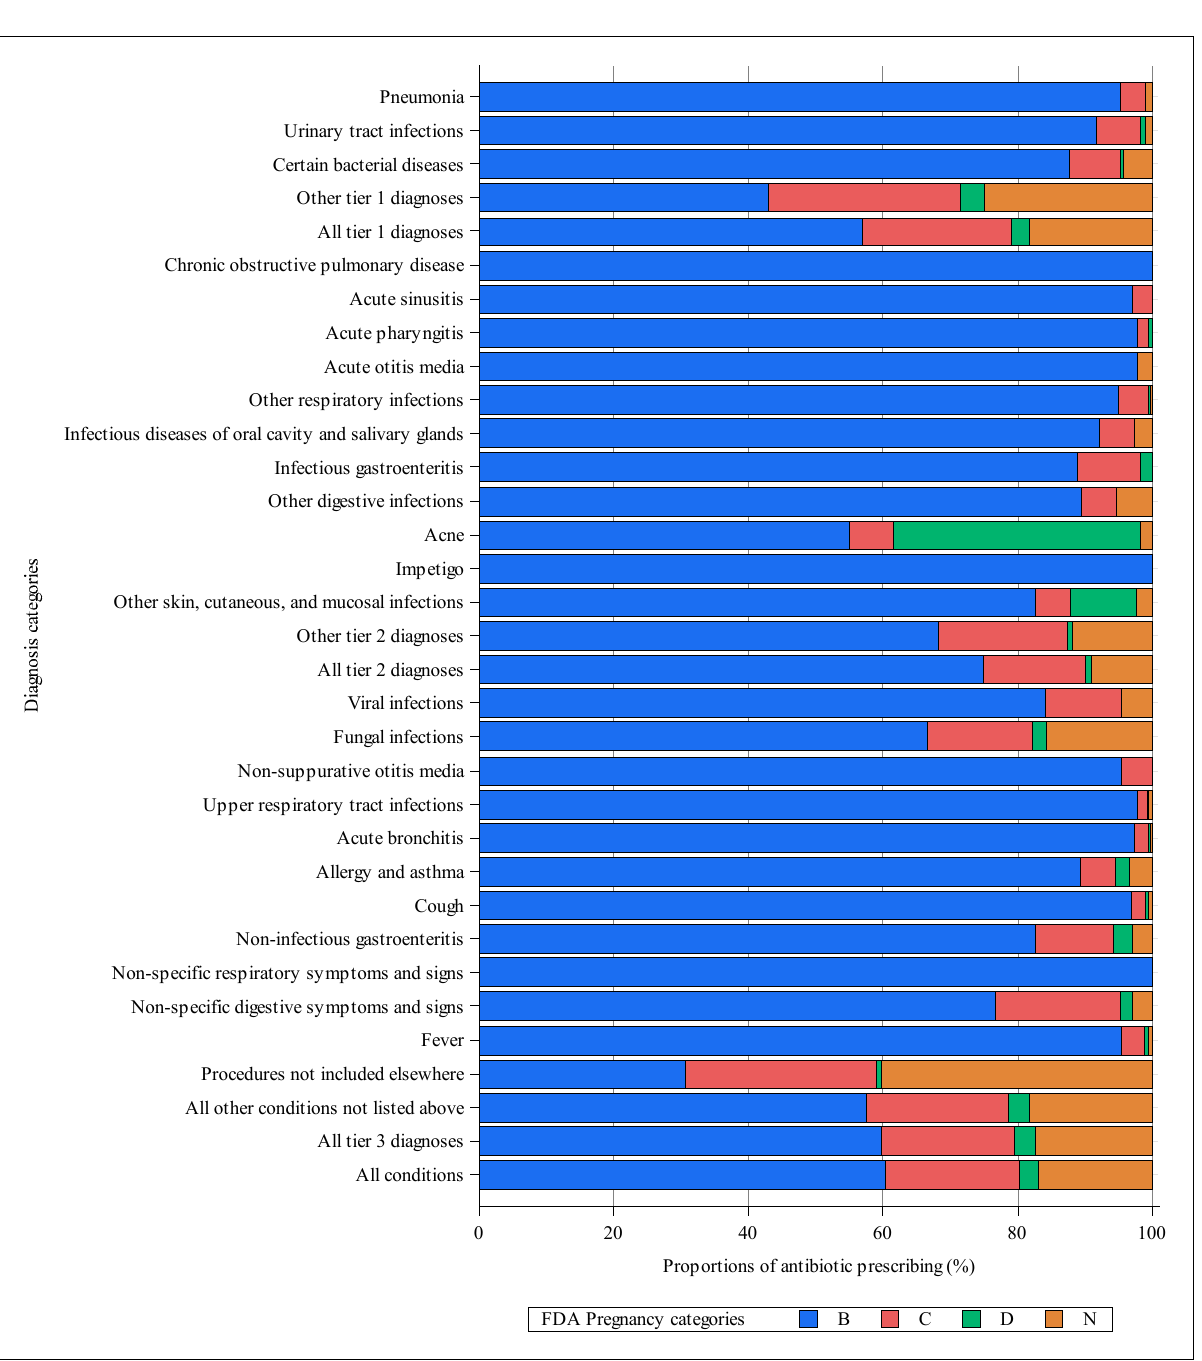
Figure 2. Proportions of antibiotics of FDA pregnancy categories within different diagnosis categories. Category N is not a FDA pregnancy category. In this study, category N referred to antibiotics that had not been assigned any FDA category.